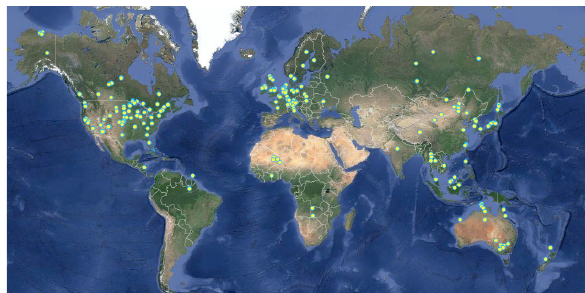
Figure 1. Distribution of 409 confluences on Google Earth examined in this study.